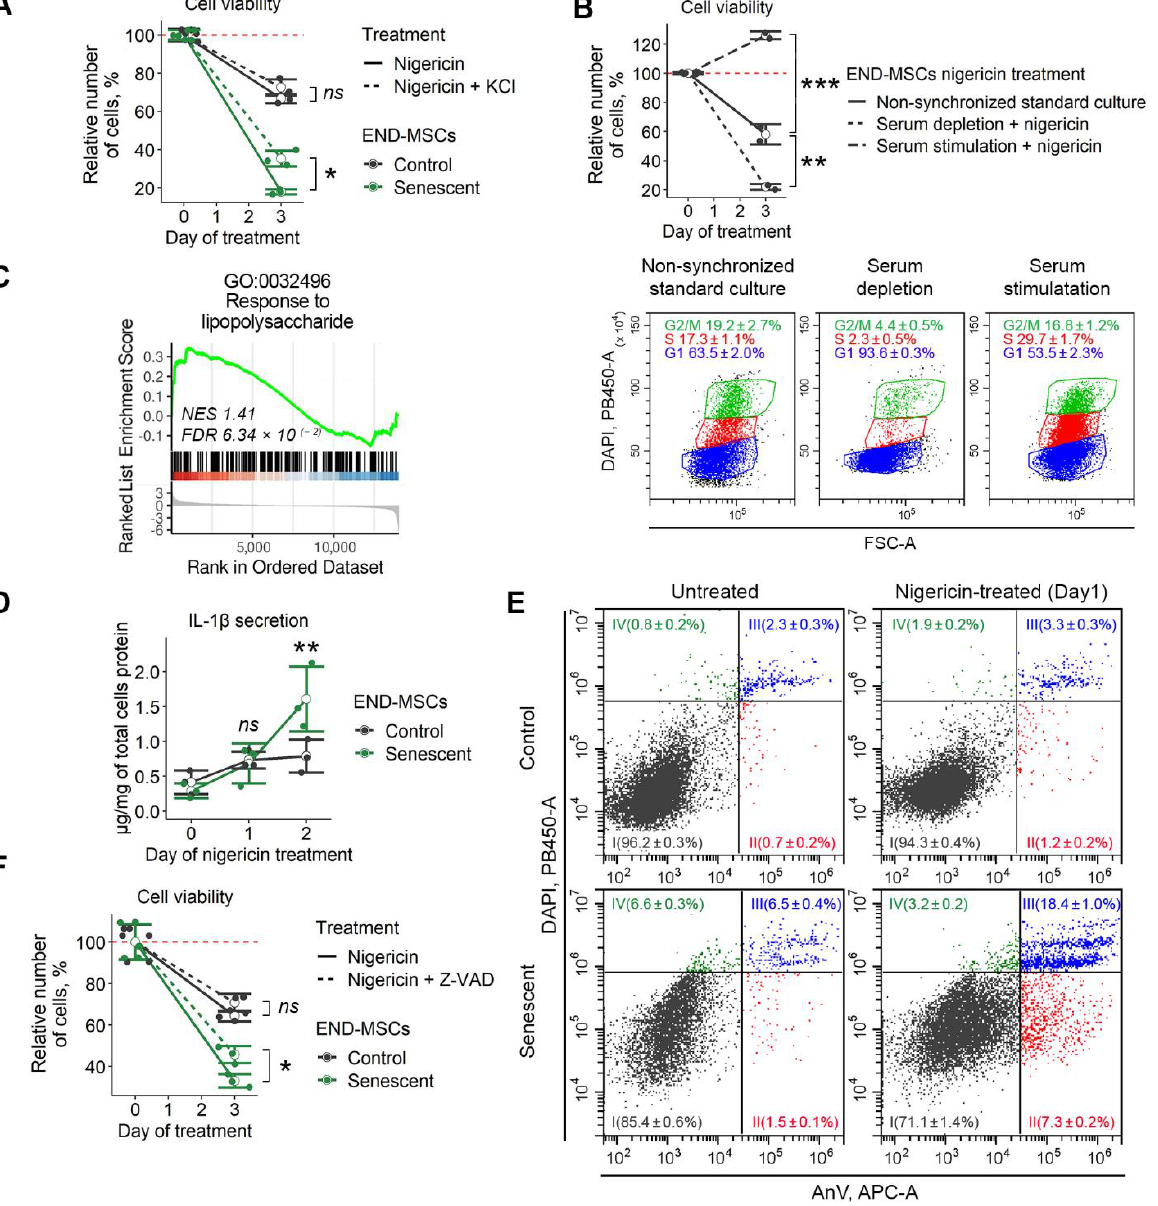
Figure 5. Nigericin treatment causes K+ efflux and initiates pyroptosis in senescent END-MSCs. Unless otherwise stated, nigericin was used at a concentration of 1 μM. ( A ) Nigericin-induced death of senescent END- MSCs was inhibited by supplementing culture media with 10 μM KCl. ( B ) Syn- chronization of control cells by serum depletion or subsequent serum level restoration modulated the toxic effect of 10 μM nigericin. ( C ) Differentially expressed genes between senescent and control END-MSCs are abundant in genes related to lipopolysaccharide-mediated pyroptotic response (Supplementary Table S2). ( D ) Nigericin treatment induced the pronounced secretion of IL- 1β in senescent END-MSCs compared to control ones. ( E ) Annexin V/DAPI double staining reveals marked death induction of senescent END-MSCs compared to control cells. ( F ) Nigericin-induced death of senescent END- MSCs was inhibited by supplementing culture media with 50 μM Z -VAD- fmk pan-caspase inhibitor. Cell viability data presented as relative cell viability (%) of control and senescent END-MSCs 3 days after treatment. Values presented are mean ± s.d. ns — not significant, * p < 0.05, ** p < 0.01, *** p < 0.005, n = 3, one- or two-way ANOVA with Tukey's HSD. We next checked the sensitivity of cells with various intracellular K + levels towards nigericin. According to our previous data, the level of intracellular K + relies significantly on the phase of the cell cycle [31]. Namely, the intracellular K + level is low in G0/G1-phase